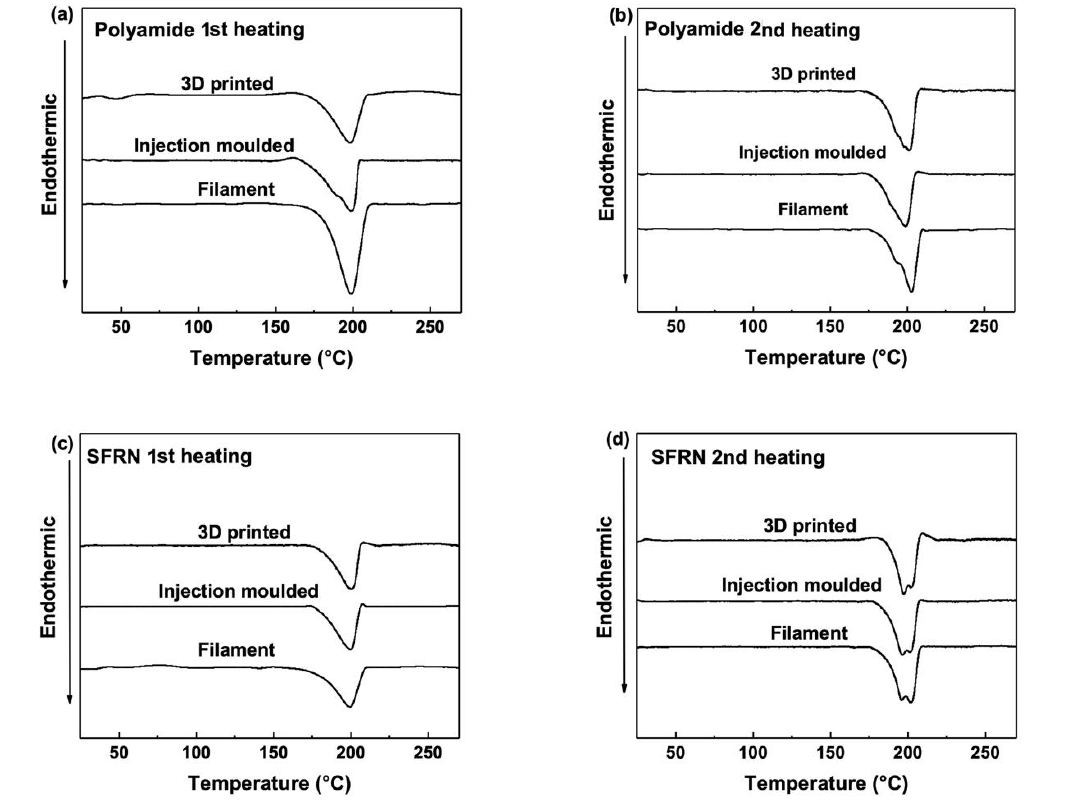
Figure 2. DSC curves of polyamide during ( a ) first heating and ( b ) second heating; SFRN composites during ( c ) first heating and ( d ) second heating.